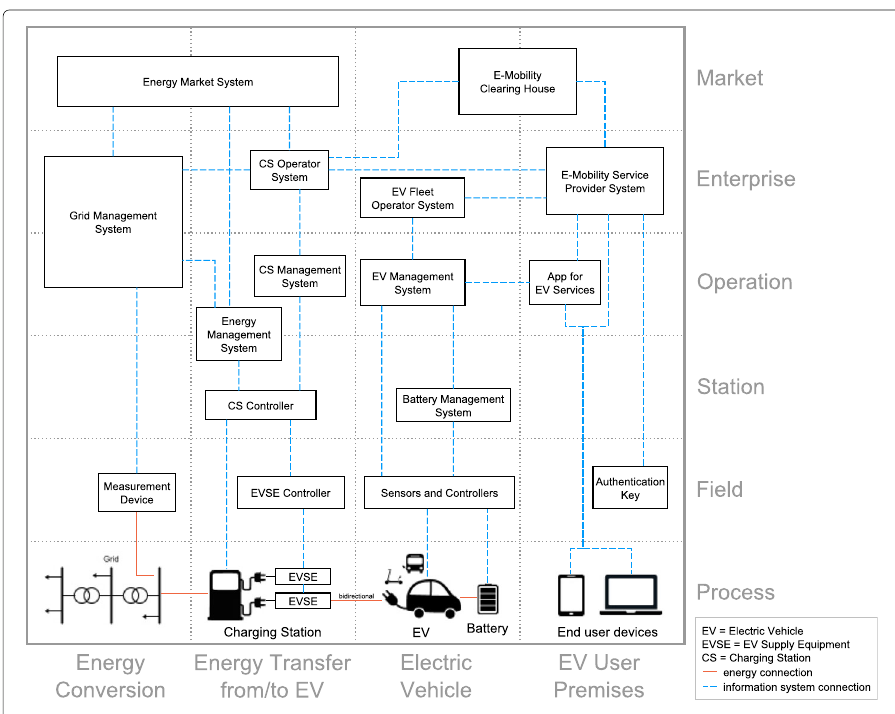
Fig. 6 EMSA component layer with relevant systems for battery e-mobility